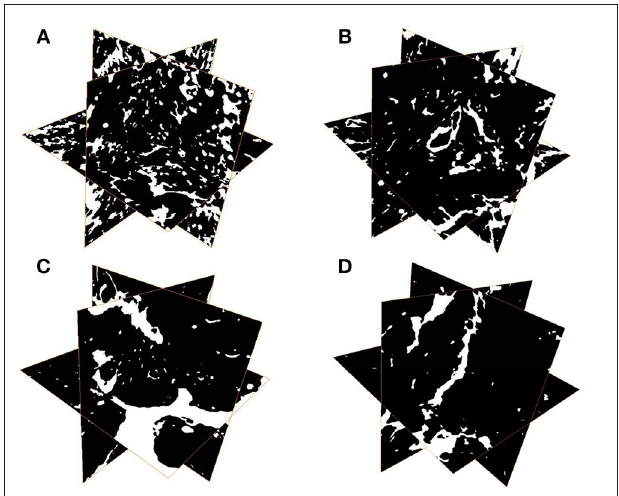
FIGURE 1 | Representative 3D pore structures of soil macroaggregates under manure treatments. (A) No manure (M0), (B) low manure (M1), (C) high manure (M2), (D) high manure plus lime (M3).